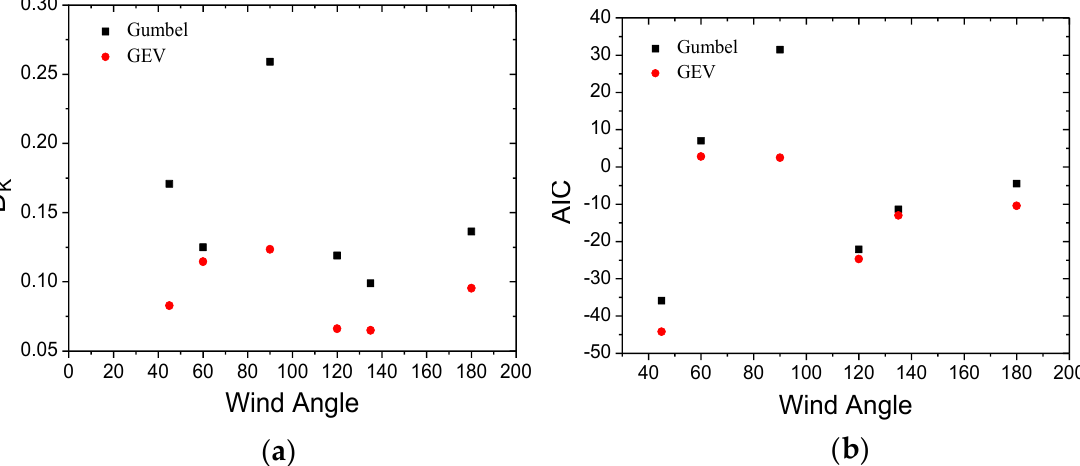
Figure 7. D K value and AIC value of extreme pressure coefficients for different wind angles. ( a ) D K of K-S test; ( b ) AIC of AIC method